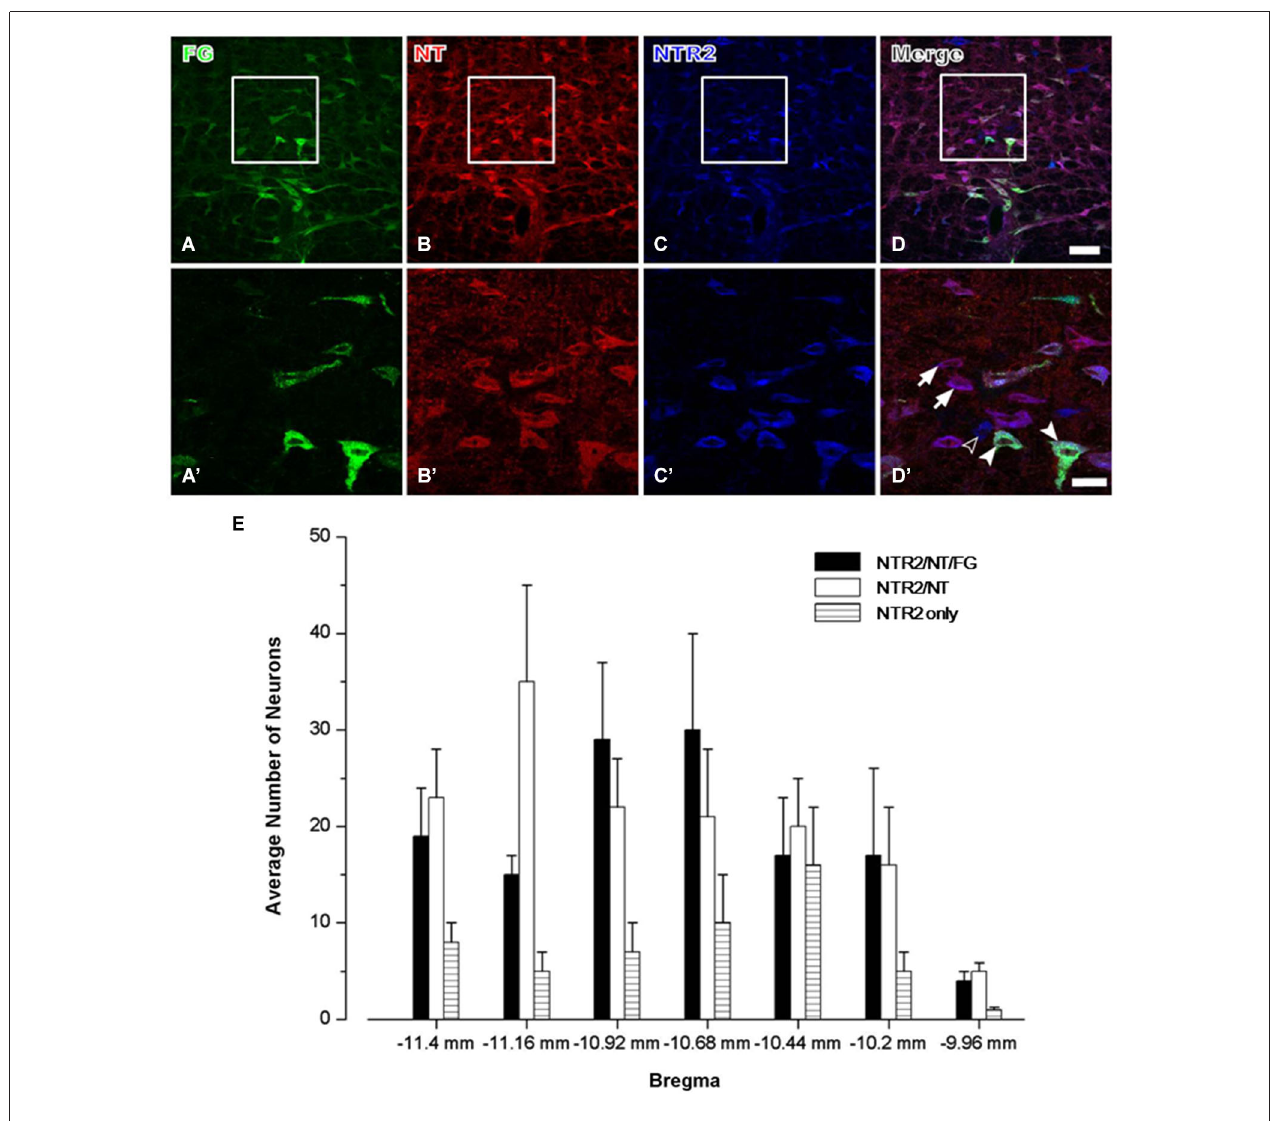
FG/NT/NTR2 triple-labeled neurons in the RVM (D’) . Scale bar = 80 µ m ( A–D) or 30 µ m (A’–D’) . (E) The mean number of NTR2-IR or NTR2/NT double-labeled or NTR2/NT/FG triple-labeled neurons in the RVM at seven rostro-caudal levels (from 11.4 mm to 9.96 mm caudal to bregma) revealed via immunofluorescence histochemical triple-staining for NTR2, NT, and FG ( n = 5